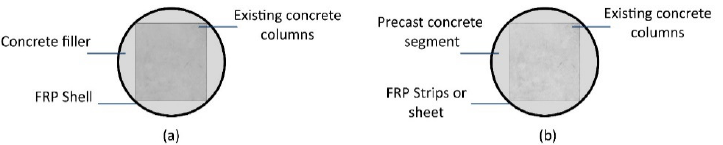
Figure 10. Transformation methods of non-circular columns: ( a ) placing prefabricated FRP shells and ( b ) using precast concrete segments.